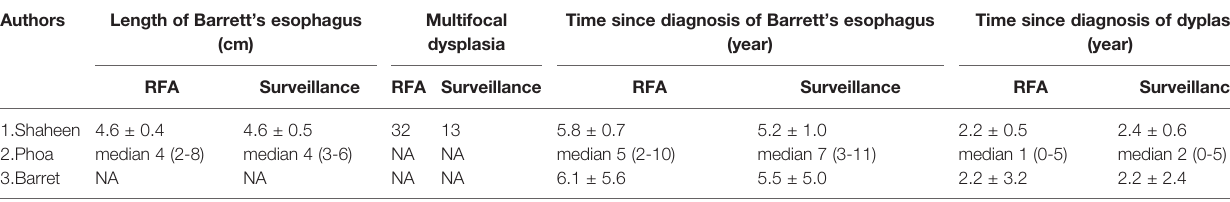
TABLE 2 | The summary characteristics of the patients in the included studies.